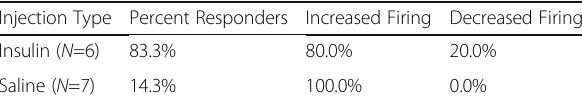
Table 1 Population results of the detected responders on insulin and saline injection experiments. Insulin injections elicited a response 83.3% of the time and tended to cause an increased rate of firing. Saline injections elicited a response 14.3% of the